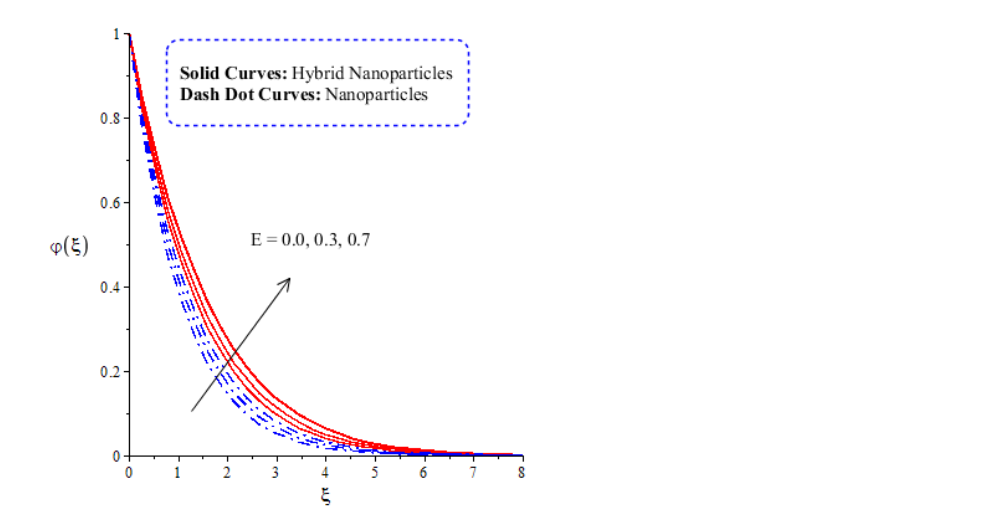
Figure 15. Comparative analysis of concentration in hybrid nanoparticles and nanoparticles with changes in 𝐸.